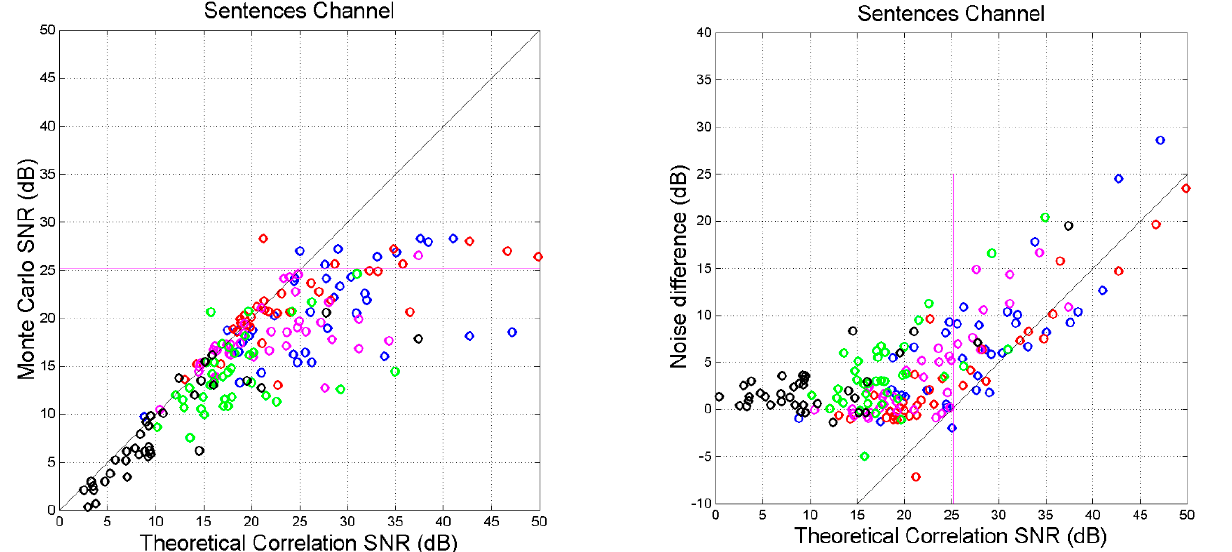
Figure 12. ( Left panel ): Scatter plot between the theoretical partial signal-to-noise ratio Γ r , dB , th and the experimental Γ r , dB , ex in the indicated cross-links. ( Right panel ): Difference Γ r , dB , th − Γ r , dB , ex , i.e., the ratio (expressed in dB) between the noise power in the experimental channel and that in the theoretical channel. Color key : blue = Mt vs. Mk; red = Mt vs. Lk; magenta = Mt vs. Jh; green = Mt vs. Ac; black = Mt vs. Ap. The magenta line corresponds to Greek